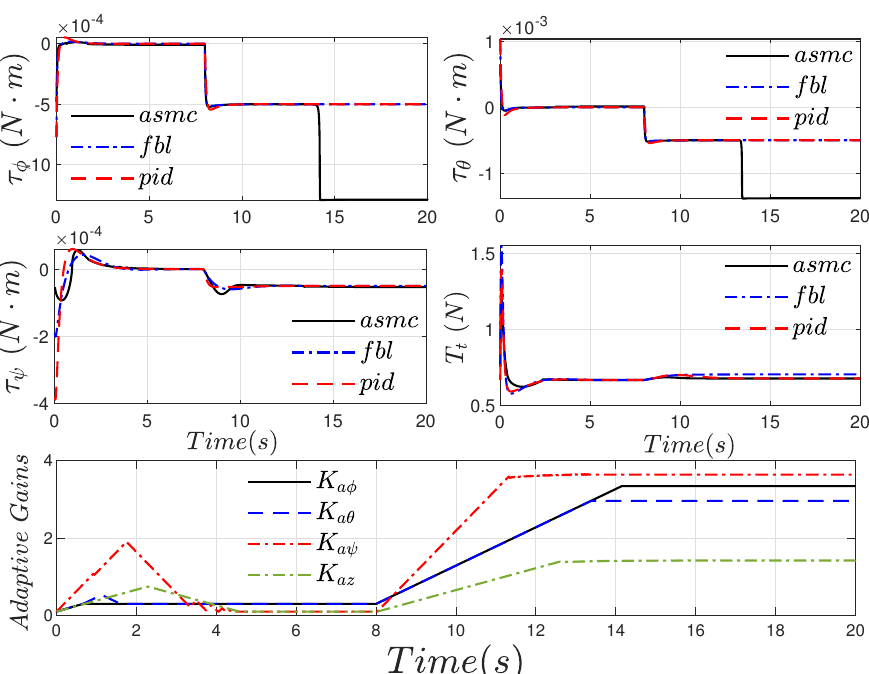
Figure 3. Regulation. Control inputs of the controllers and adaptive gains of the